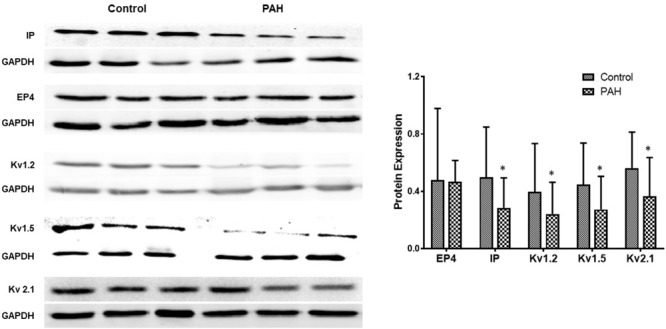
The figure shows representative Western blots of IP, EP4 receptors and Kv channels in human pulmonary arteries and mean data from non PAH (control; n = 11, male = 5) and PAH patients (n = 12, male = 6) undergoing surgery for CHD repair or lung cancer. The panel shows Western blots of protein expression. A different gel was used for each receptor and the respective GAPDH band is shown for each. Results are mean ± SD. ∗p < 0.05 PAH vs. control.